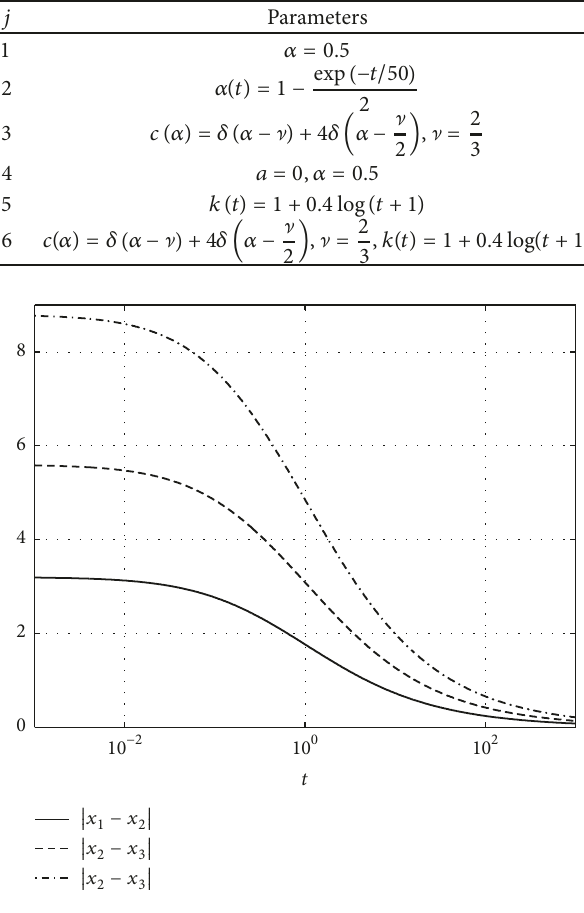
Figure 4: Linear case, 𝑗 = 3